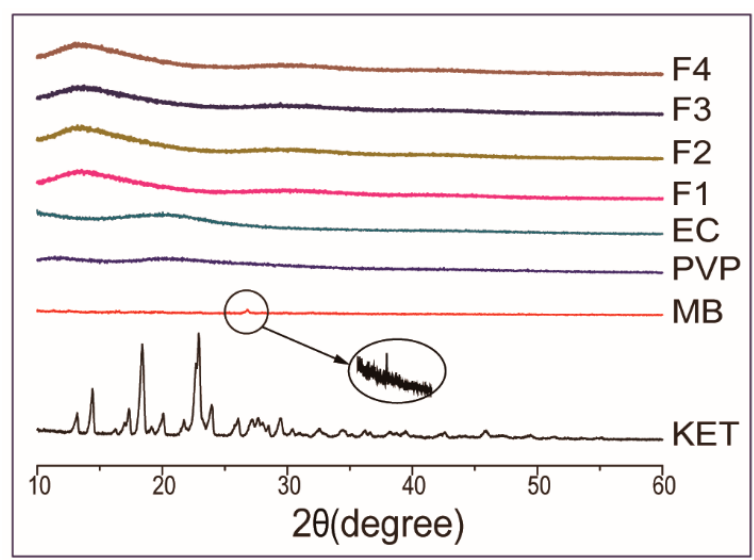
Figure 4. XRD patterns of raw powders and Janus nanostructures.